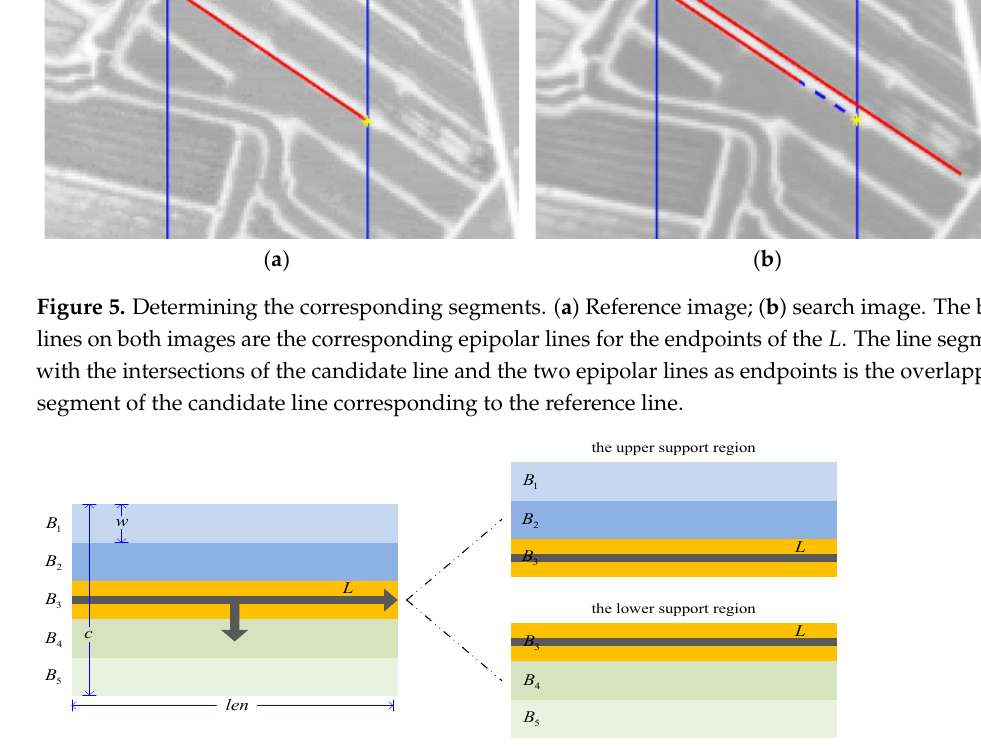
Figure 5. Determining the corresponding segments. ( a ) Reference image; ( b ) search image. The blue lines on both images are the corresponding epipolar lines for the endpoints of the L . The line seg- ment with the intersections of the candidate line and the two epipolar lines as endpoints is the over- lapping segment of the candidate line corresponding to the reference line.